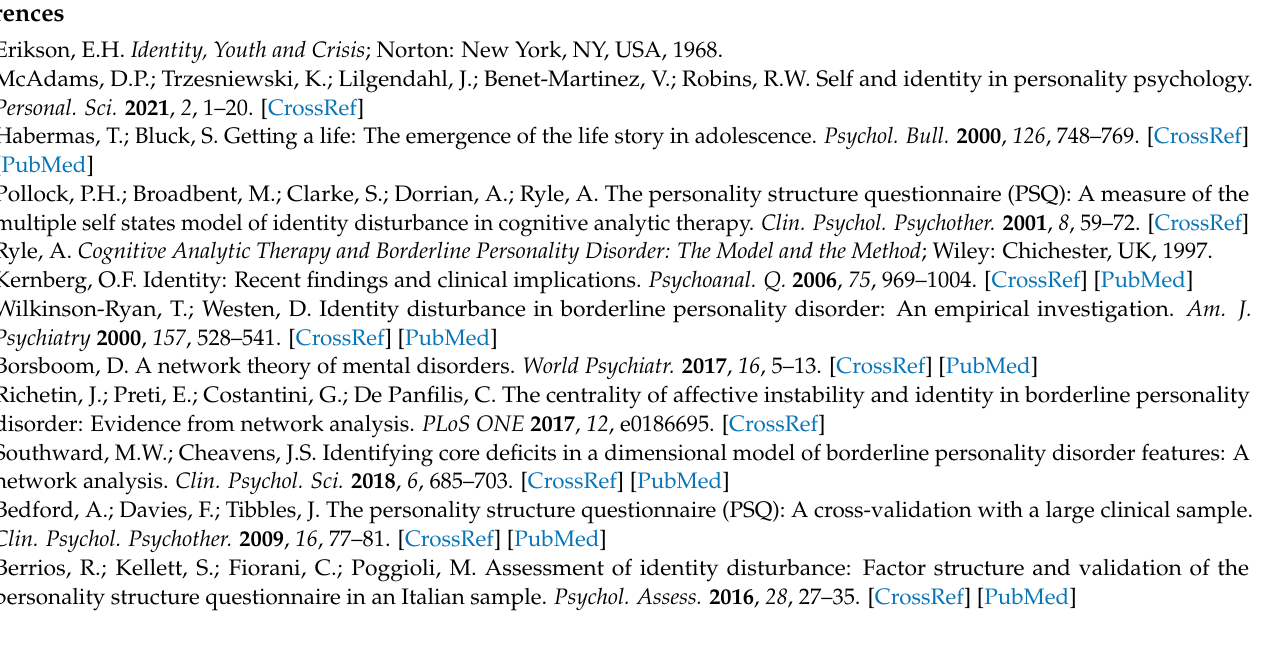
ples; Figure S2: Clinical versus community subsamples; Figure S3: Complex mental health versus common mental health problem